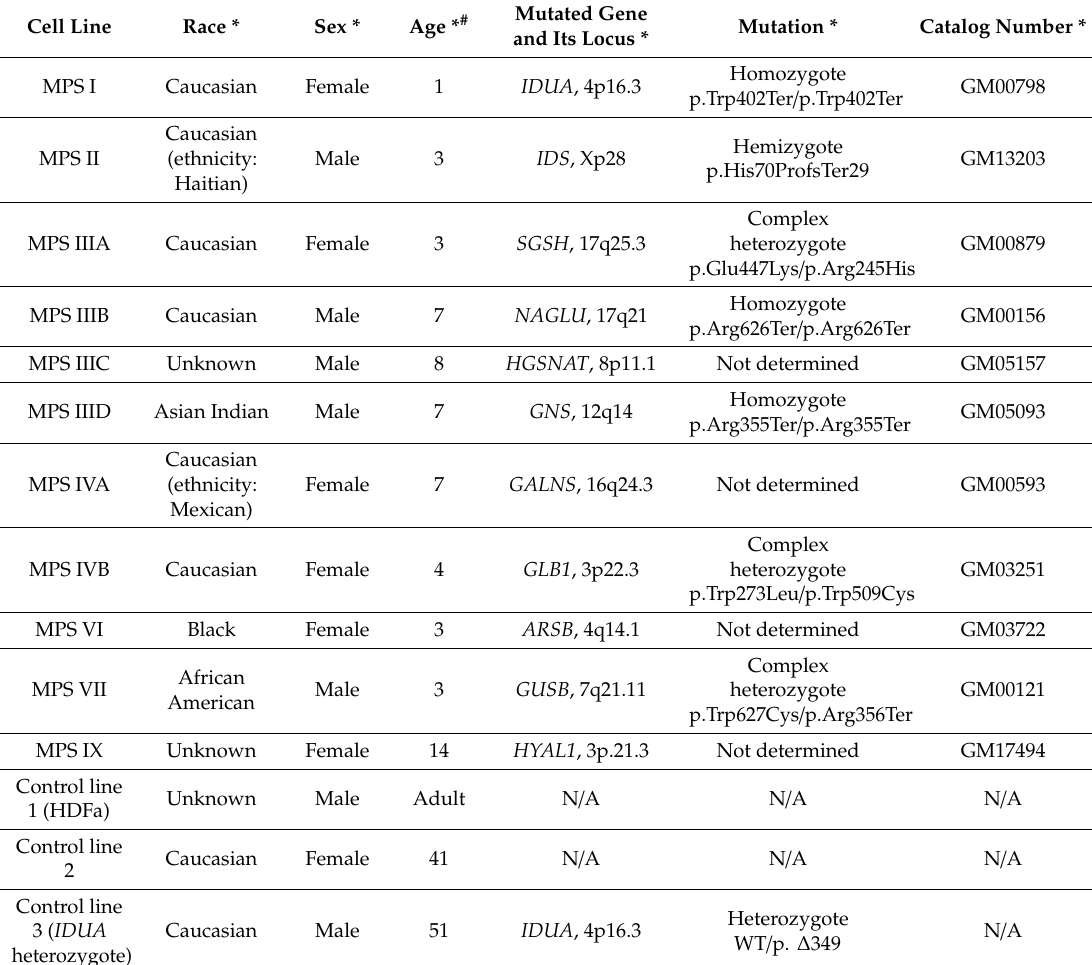
Table 2. Characteristics of fibroblast lines derived from MPS patients and control cell